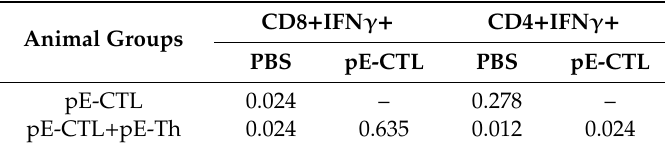
Table 4. Statistical analysis results obtained using intracellular cytokine staining